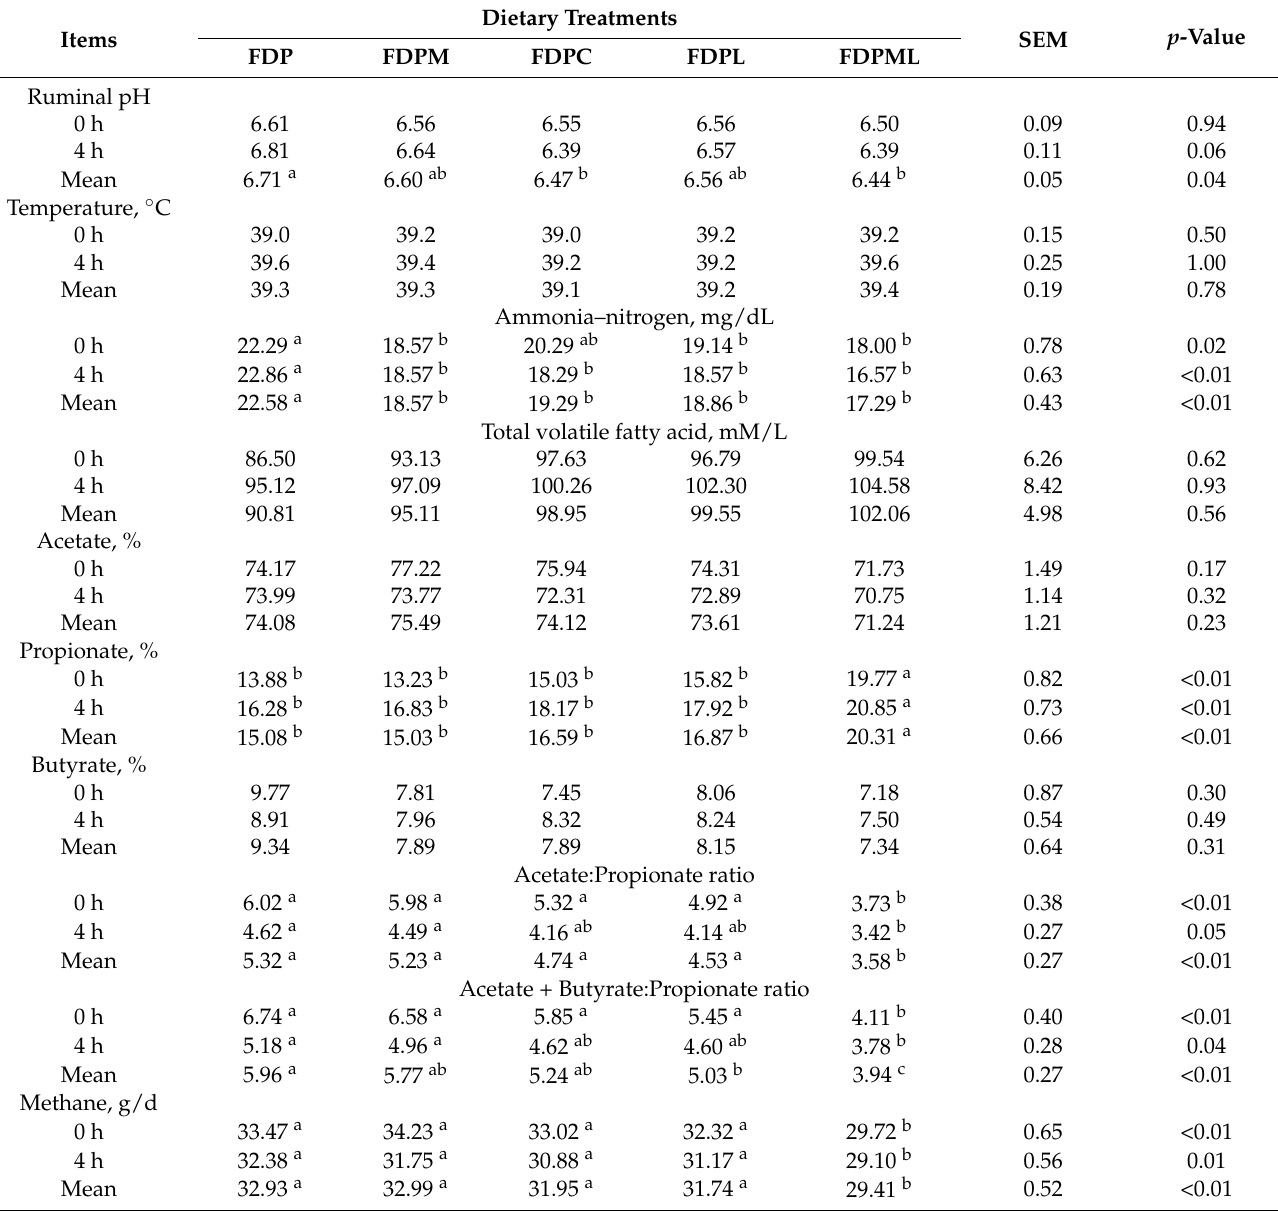
Table 4. Effects of untreated and treated discarded durian peel on rumen characteristics in growing